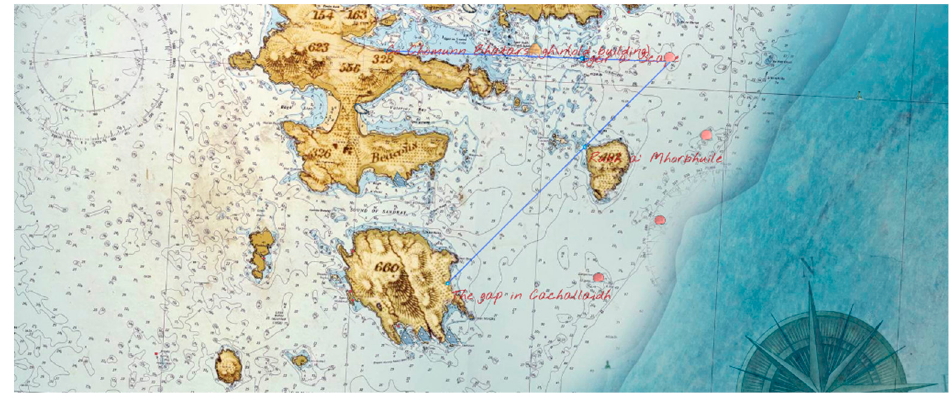
Figure 11. Screenshot of the Cullen shipwreck story in Sea Stories website. Reproduced with permission of the artist. Image used with permission form the artist.